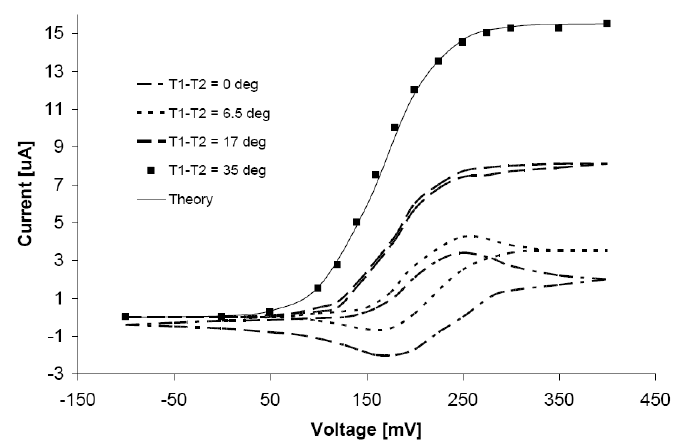
Figure 4. The change of cyclic voltammetry with application of thermal gradient. The ■ points are experimental points, and the continuous line is the theoretical run of function 1/(1 + exp (( nF. ( E-E 0 )/ RT